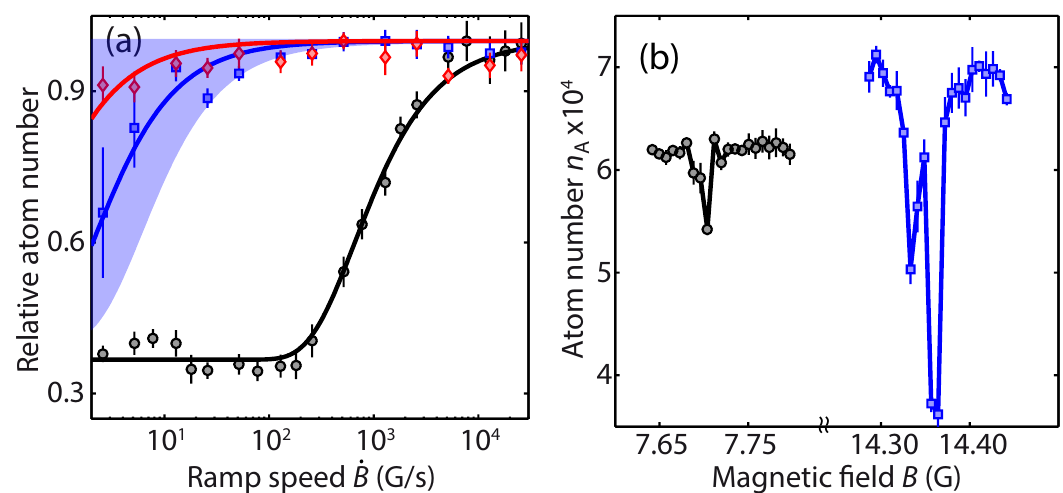
Figure 2: (a) Relative atom number after ramping across the Feshbach resonance at 14.3G (circles), 7.7G (squares) and 3.7G (diamonds) as a function of the ramp = 20 E = 30 E speed ˙ B . Here, the lattice depth V ( V ) for the resonance at x , y , z R x , y , z R 14.3G (7.7G and 3.7G). Solid lines are fits to the data using Eq. 1 with ∆ B as free parameter, giving ∆ B = 14.0 ( 0.9 ) mG (circles), ∆ B = 8.0 ( 1.6 ) µ G (squares), and ∆ B = 1.2 ( 0.4 ) µ G (diamonds). The shaded area indicates the uncertainty region 0 µ G < ∆ B < 20 µ G for the 7.7G resonance as explained in the text. (b) Remain- ing atom number n starting from an initially singly occupied Mott insulator state at A = 20 E = 5000ms (circles) and around V as a function of B around 7.7G with t x , y , z R H = 50ms (squares). Solid lines connect the data points and are guides 14.3G with t H to the